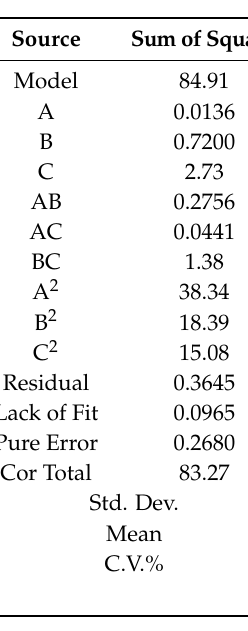
Table 3. ANOVA for quadratic response surface regression